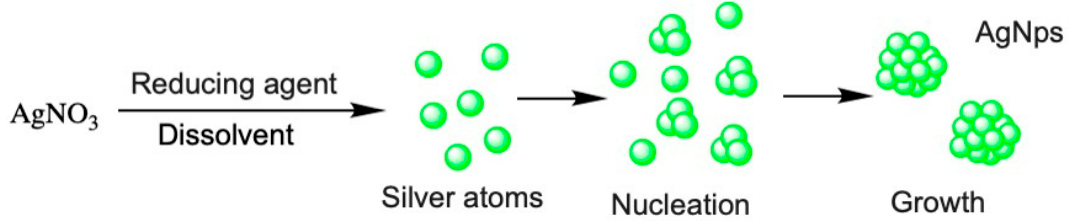
Figure 3. Process for the synthesis of AgNPs.